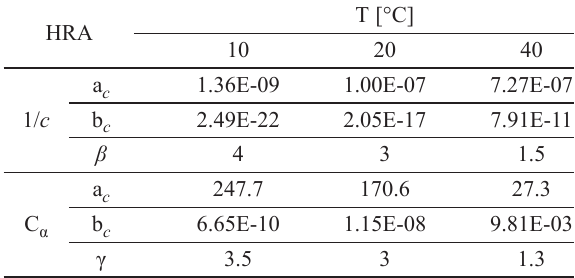
Table 3. Coefficients in Eqn (12a,b) for DBM DBM